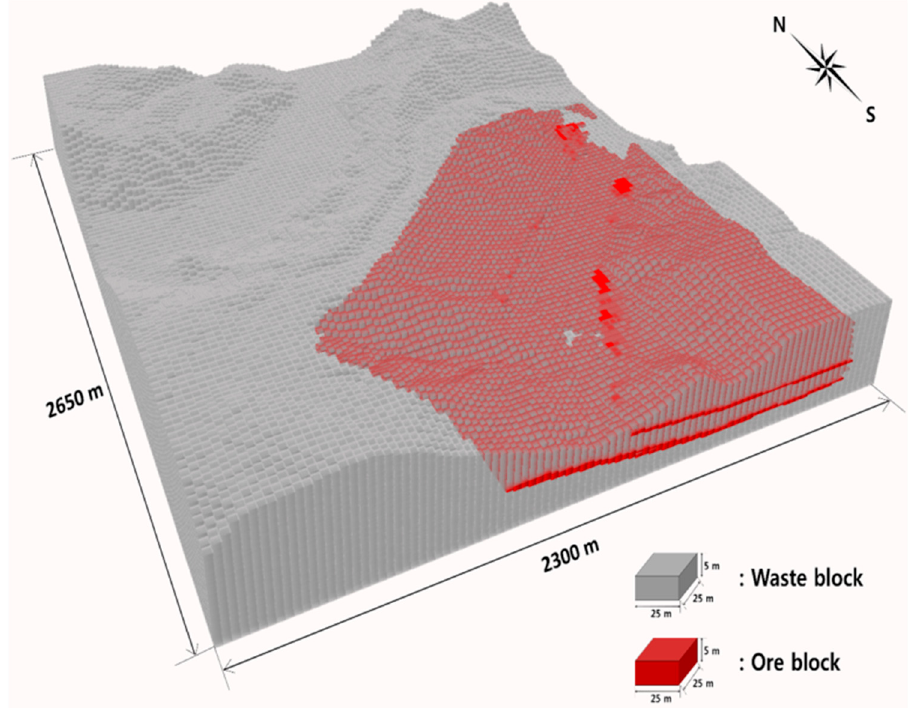
Figure 3. Block model of copper-zinc deposits in the study area.